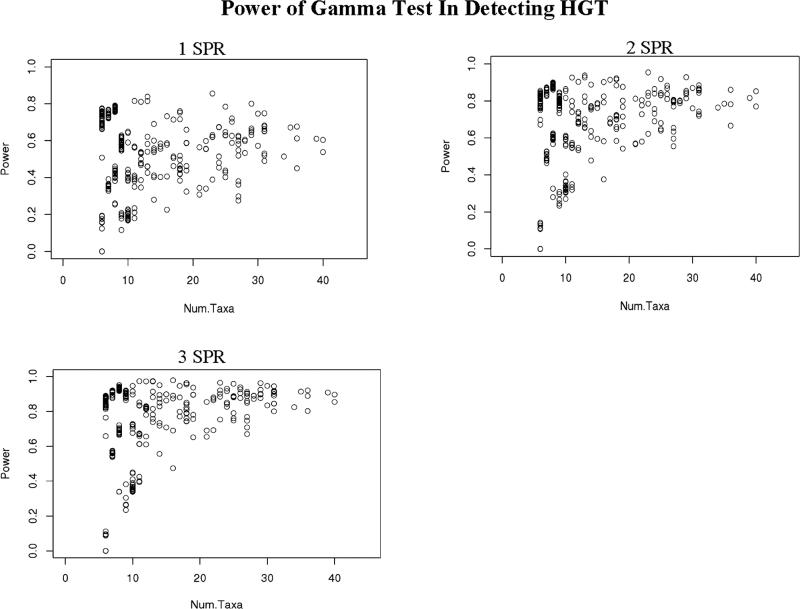
Power of the γ Test in Detecting HGTRandom SPR operations were applied to each COG tree to assess the power of the γ test. The figures show the power values plotted against the taxon numbers in the COG entries for 1, 2, and 3 SPR changes.